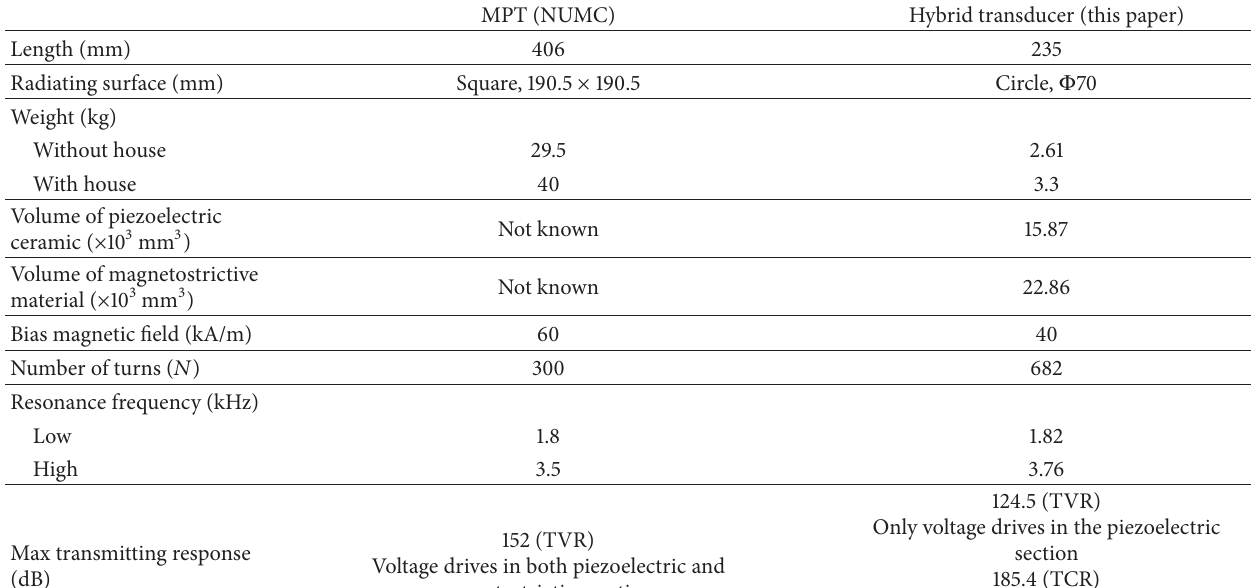
Table 4: Comparison between MPT (NUMC) and Hybrid transducer (this paper).